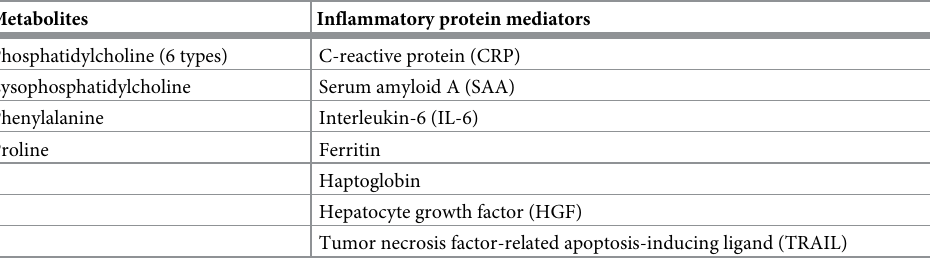
Table 3. List of the most significant metabolites and inflammatory protein mediators identified in children with